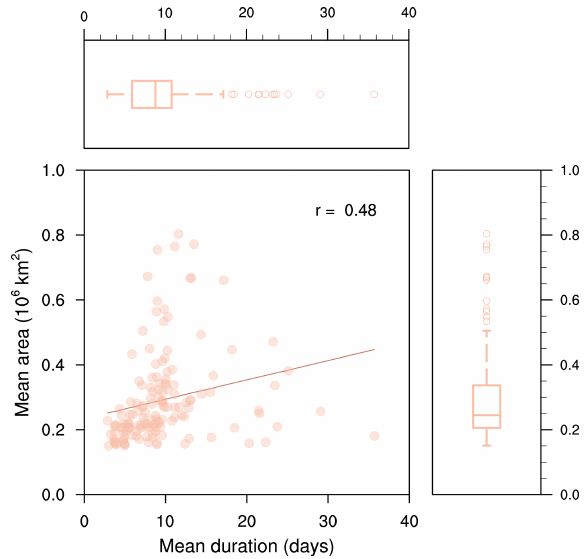
Figure 7. Scatterplot of mean duration and mean area for each spatiotemporal compound long-duration dry and hot event during 1961–2014. The red line is a least-squares line of best fit. The Spear- man correlation coefficient ( r = 0.48, p< 0 . 05) is shown in the fig- ure. The upper and right panels show the boxplot of mean duration and mean area, respectively. The box represents the interquartile range with the horizontal line indicating the median, with whiskers expanding from the minimum to the maximum and outliers being shown as